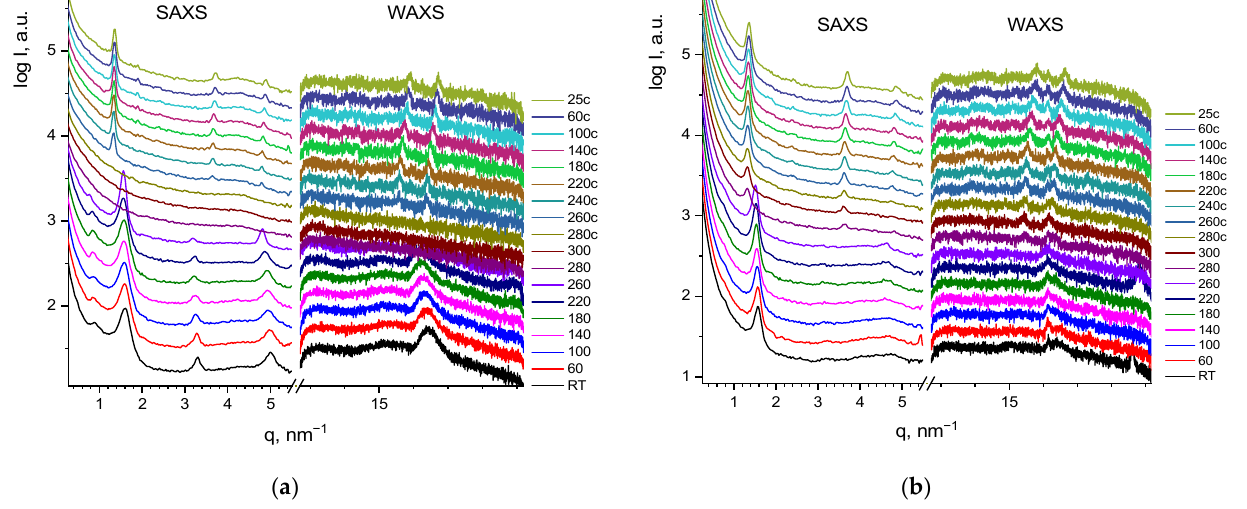
Figure 4. SWAXS curves for annealed G1 ( a ) and G2 ( b ) at varied temperatures. The curves are shifted vertically for clarity.